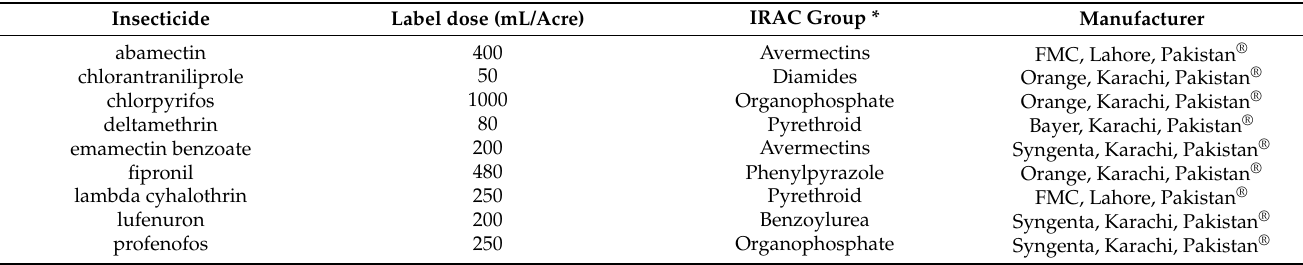
Table 3. Description of synthetic insecticides bioassayed against 3rd instar larvae of the fall armyworm Spodoptera frugiperda